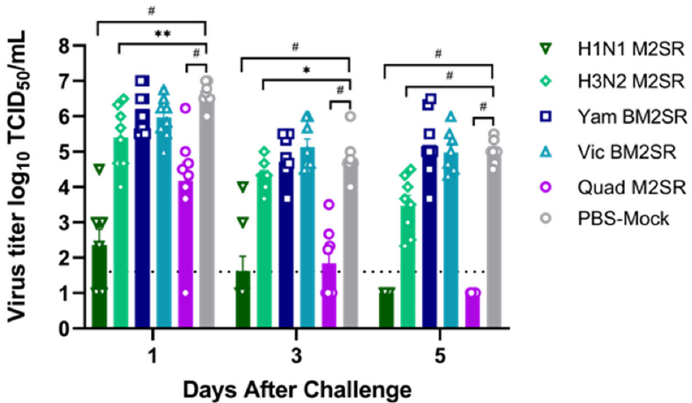
Figure 8. Nasal wash titers from M2SR-vaccinated ferrets following the challenge with the H1N1 influenza virus. Nasal washes were collected on days 1, 3, and 5 post-challenge. Virus loads in samples were determined by a TCID 50 assay in MDCK cells. Open faced symbols (e.g., triangles, diamonds, circles, etc.) represent virus titers from individual mice within the group, while colored bars represent the mean titer for the indicated group. The detection limit of the assay was 1.5 log 10 TCID 50 /mL, as indicated by a horizontal dotted line. Solid symbols above horizontal black bars (e.g., *, #) indicate results that were significantly different from those of the PBS-Mock group: * p < 0.05, ** p < 0.005, and # p < 0.0005, as compared by an unpaired t test.